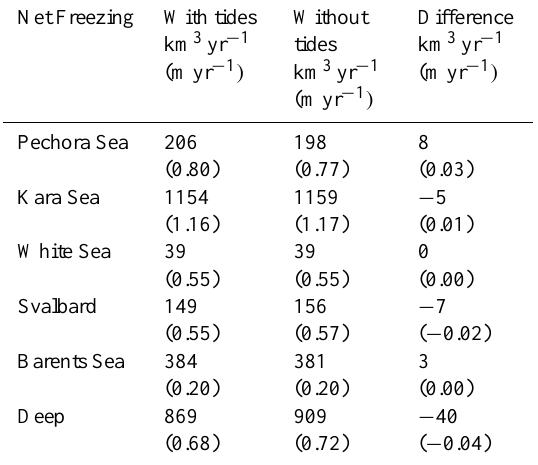
Table 2. Net melting integrated over the subdomains indicated in Fig. 2b for the model run with tides, the control run without tides and the differences between them (km 3 yr − 1 ) . Also shown in brackets is the ice thickness decrease brought about by this amount of net melting when averaged over each subdomain (myr − 1 )